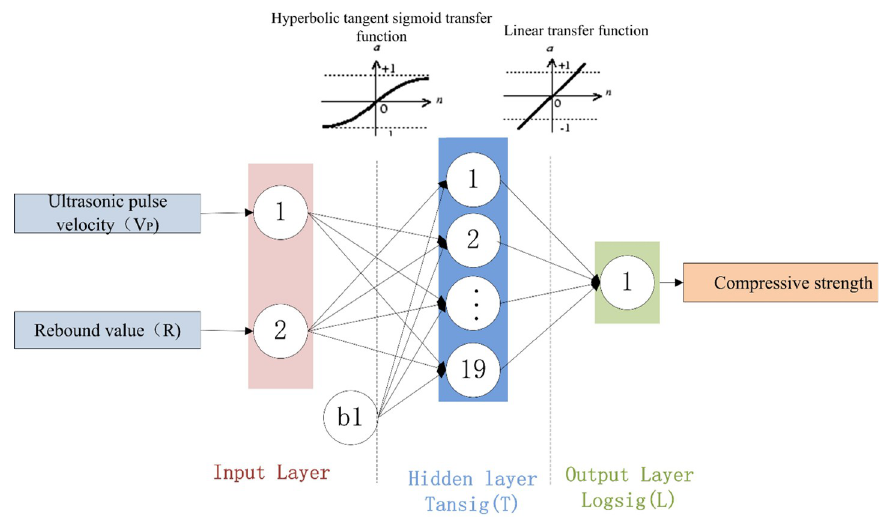
Fig 17. Optimal BPNN structure with two input parameters.